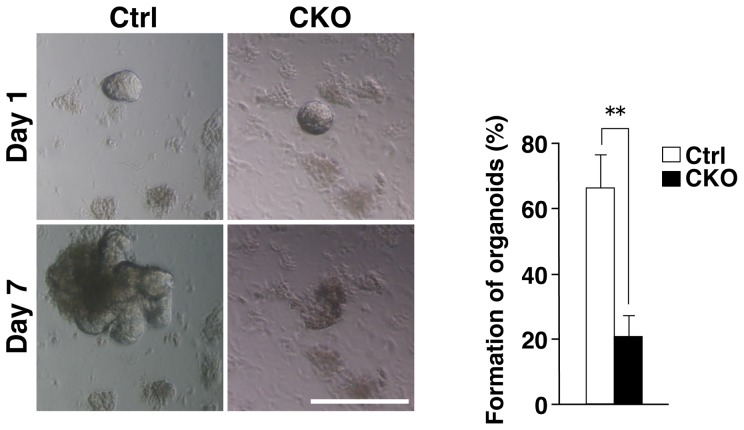
Impaired development of intestinal organoids from Shp2 CKO mice.Representative images of intestinal organoids derived from the jejunum of control or Shp2 CKO mice at 1 and 7 days after plating are shown in the left panel. Scale bar, 100 μm. The number of intestinal organoids with a crypt-villus structure at 7 days after plating was determined as a percentage of those with a spherelike morphology (diameter of >30 μm) at 1 day (right panel). Data are means ± SE for a total of 151 (control) or 128 (Shp2 CKO) organoids in four independent experiments. **P<0.01 (Student's t test).